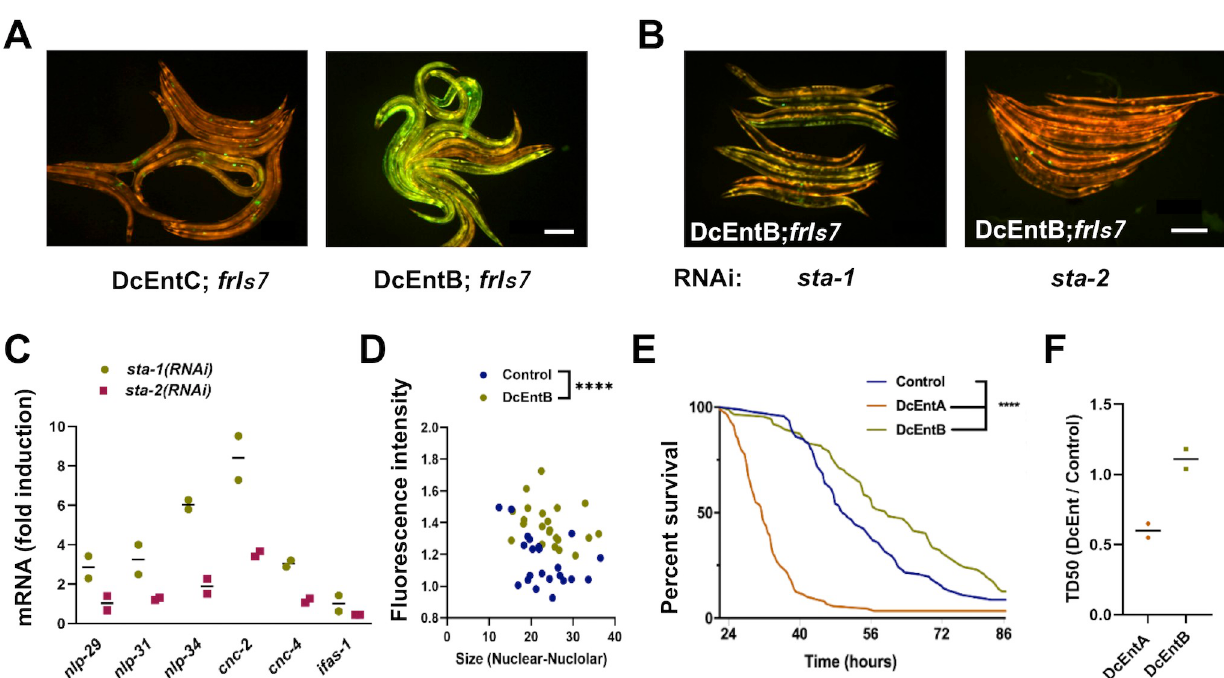
Fig 8. DcEntB induces AMP gene expression in a sta-2 -dependent manner. ( A , B ) Representative images of adult worms, 3 days after the L4 stage, carrying frIs7 and expressing DcEntC (IG1883) or DcEntB (IG1941) on E . coli OP50 ( A ) or following RNAi against sta-1 or sta-2 ( B ). frIs7 includes nlp- 29p :: GFP and col-12p :: dsRed transgenes; red and green florescence is visualized simultaneously. Scale bar, 200 μ m. A difference in GFP levels for worms with frIs7 between OP50 and RNAi (HT115) bacteria has been observed regardless of the genetic background. ( C ) Quantitative RT-PCR analysis of the expression of nlp , cnc and ifas-1 genes in worms expressing DcEntB (IG1941) following RNAi against sta-1 or sta-2 . Results from 2 independent experiments are shown relative to the expression levels in age-matched control (hygR; frIs7 IG1864) worms. ( D ) Intensity of green fluorescence in the nuclei of DcEntB;STA-2::GFP worms (DcEntB, IG1977, green), and their siblings without the DcEntB transgene (Control, blue), plotted against the nuclear-nucleolar size, measured using ImageJ. Each dot represents a nucleus; n > 20, ���� p < 0.0001, unpaired t-test. ( E ) Survival of control (IG1864) worms and worms expressing DcEntA (IG1942) or DcEntB (IG1941) after infection as young adults with a concentration of D . coniospora spores 10 times higher than usual at 25˚C (n = 92, 91 and 87 respectively). ���� p < 0.0001, one-sided log rank test. The curves here are representative of 2 independent biological replicates for which the ratio of median survival (TD50) between worms expressing DcEntA or DcEntB to control worms are shown in ( F ).